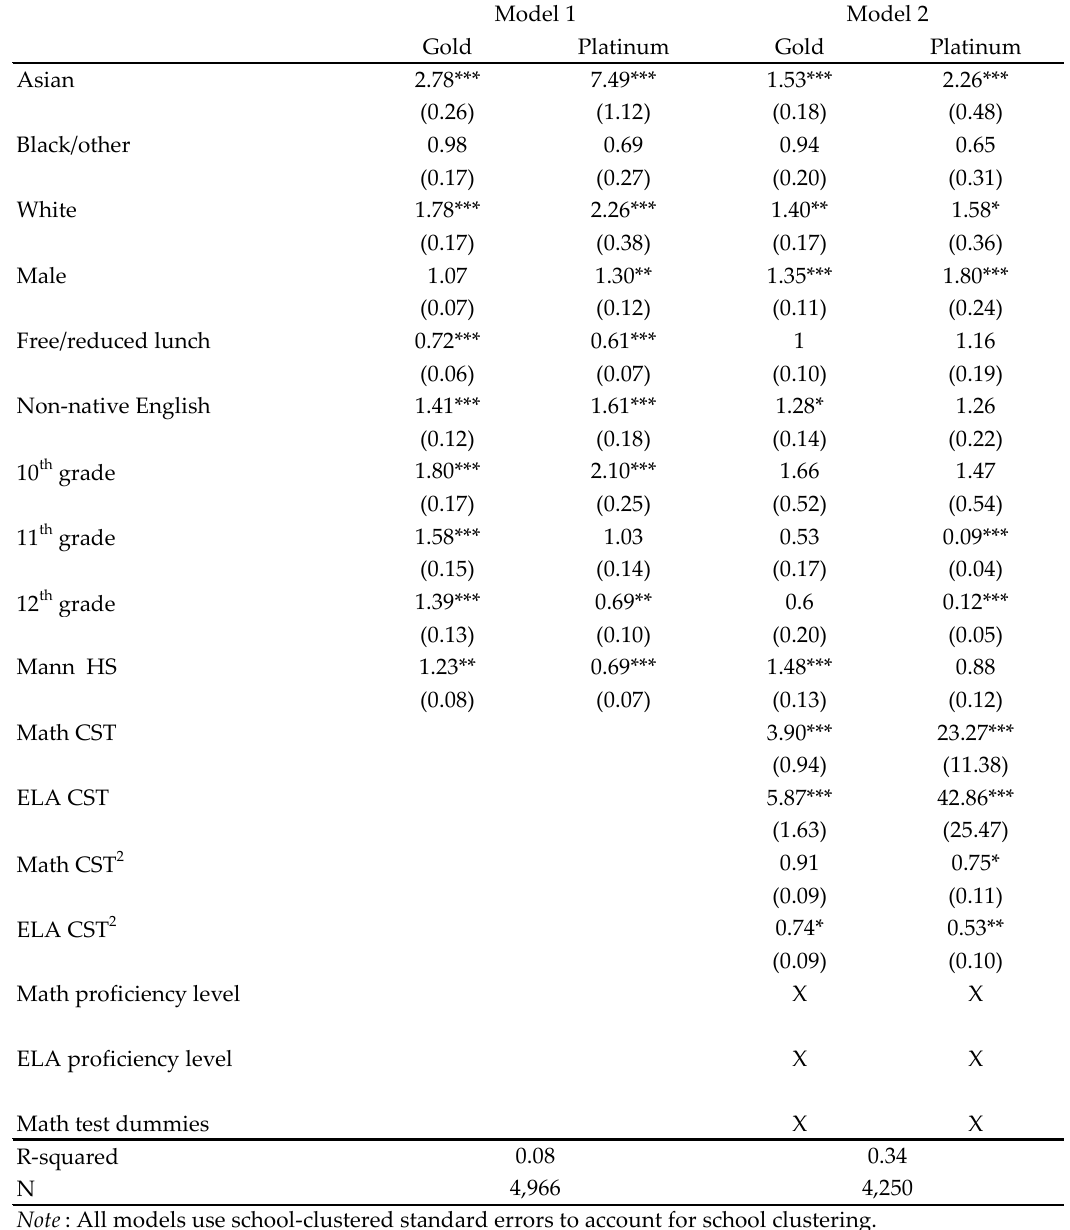
Table S1: Multinomial logistic regression – odds of receiving a gold or platinum card (2012 Live